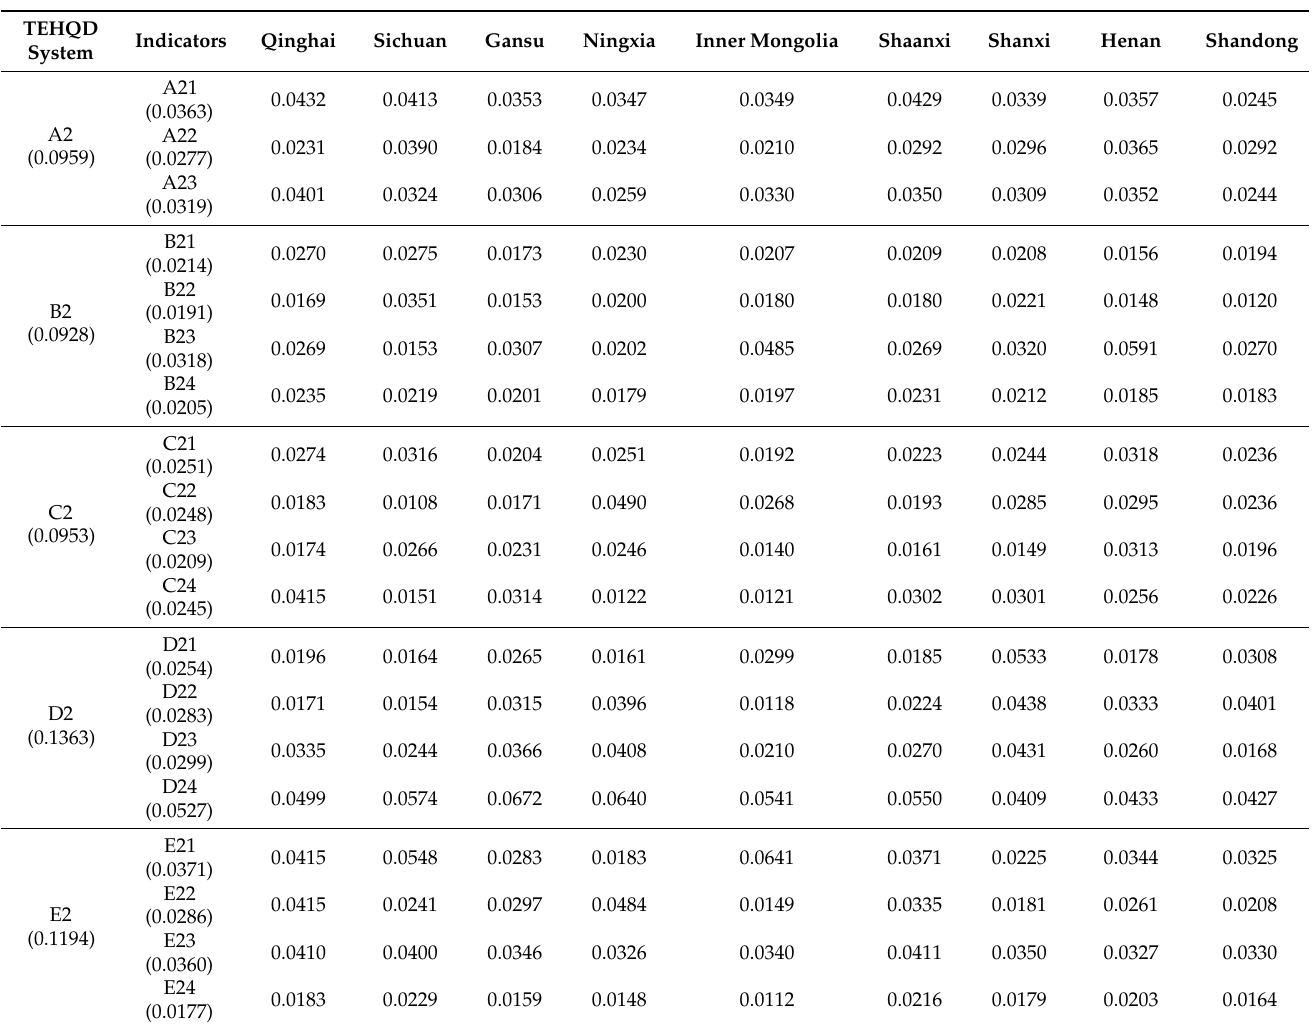
Table 6. Weight of the tourism economy’s high-quality development (TEHQD) evaluation index of the nine provinces in the Yellow River